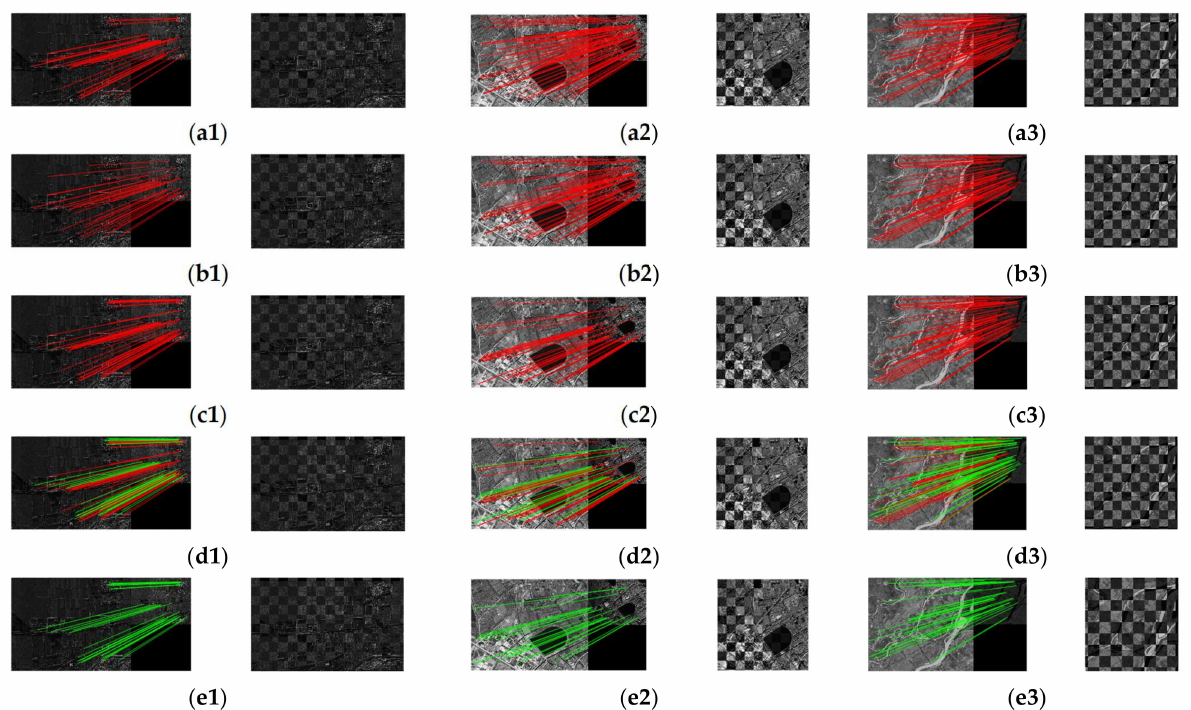
Figure 15. Registration result and mosaic diagram: ( a1 – a3 ) UND-Harris. ( b1 – b3 ) SAR-Harris. ( c1 – c3 ) Har-Lap. ( d1 – d3 ) Har-DoG. ( e1 – e3 ) DoG. Where the red lines denote the corners, and the green lines denote the